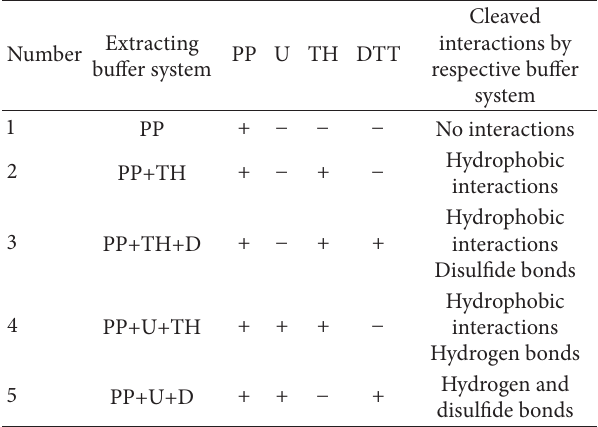
Table 1: Combinations of selective reagents and the cleaving effect of these